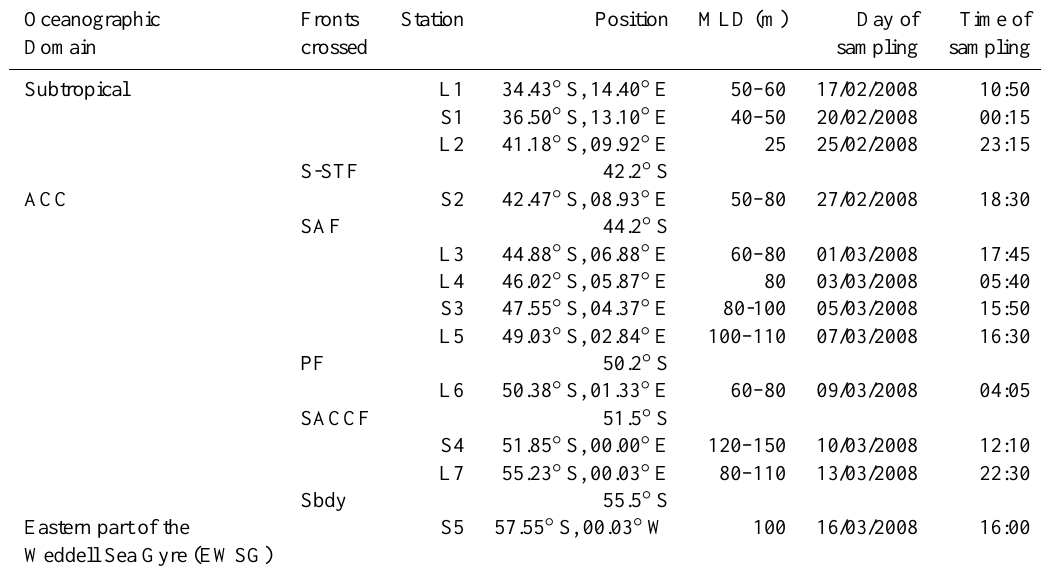
Table 1. Location of the stations sampled during the cruise in relation to the domains and fronts crossed. Mixed layer depth observed from the vertical profile of temperature for nearby CTD station, as well as day and time of sampling are indicated. Dates are in DD/MM/YYYY format (D=day, M=month and